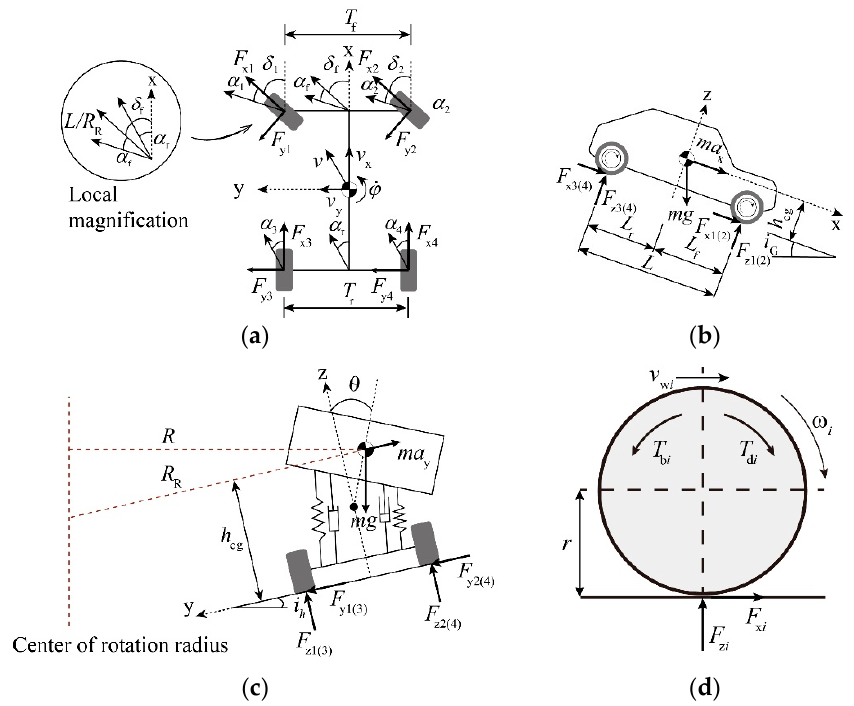
Figure 1. 8DOF multibody model with superelevation and longitudinal slope variables. ( a ) Top view. ( b ) Side view. ( c ) Rear view. ( d ) Mechanical characteristics of the tire.